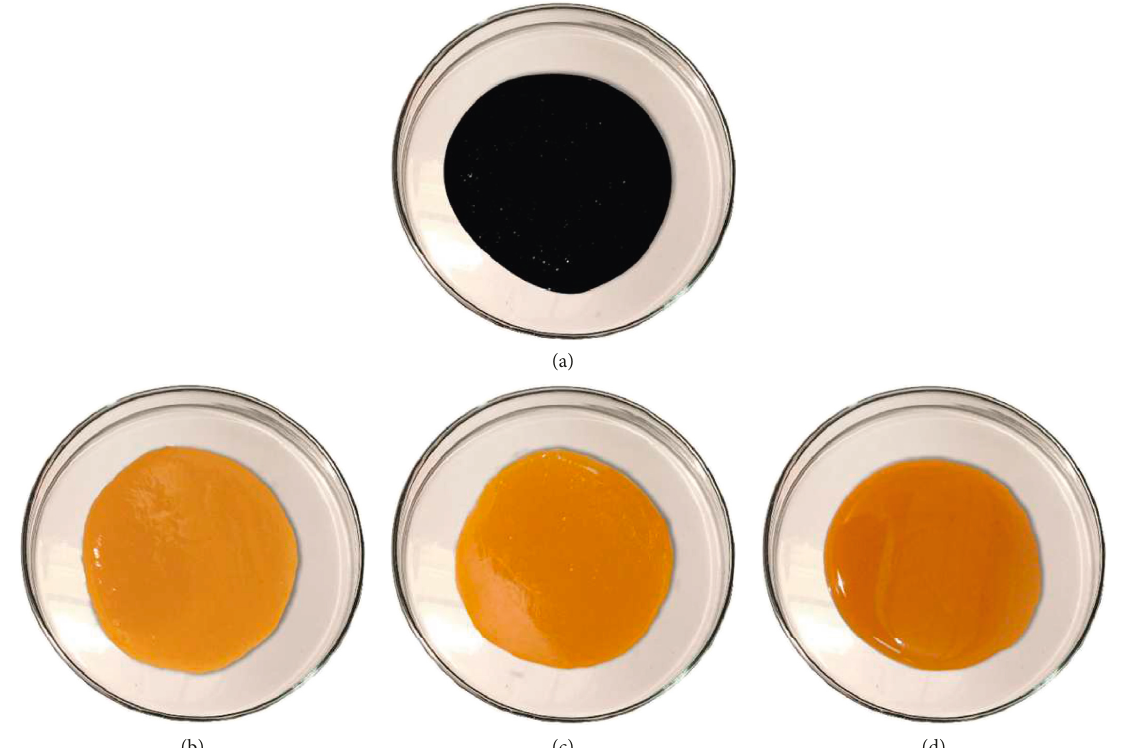
Figure 7: Acquired pictures: bitumen (a); unaged CSR (b); RTFO-aged CSR (c); PAV-aged CSR (d).